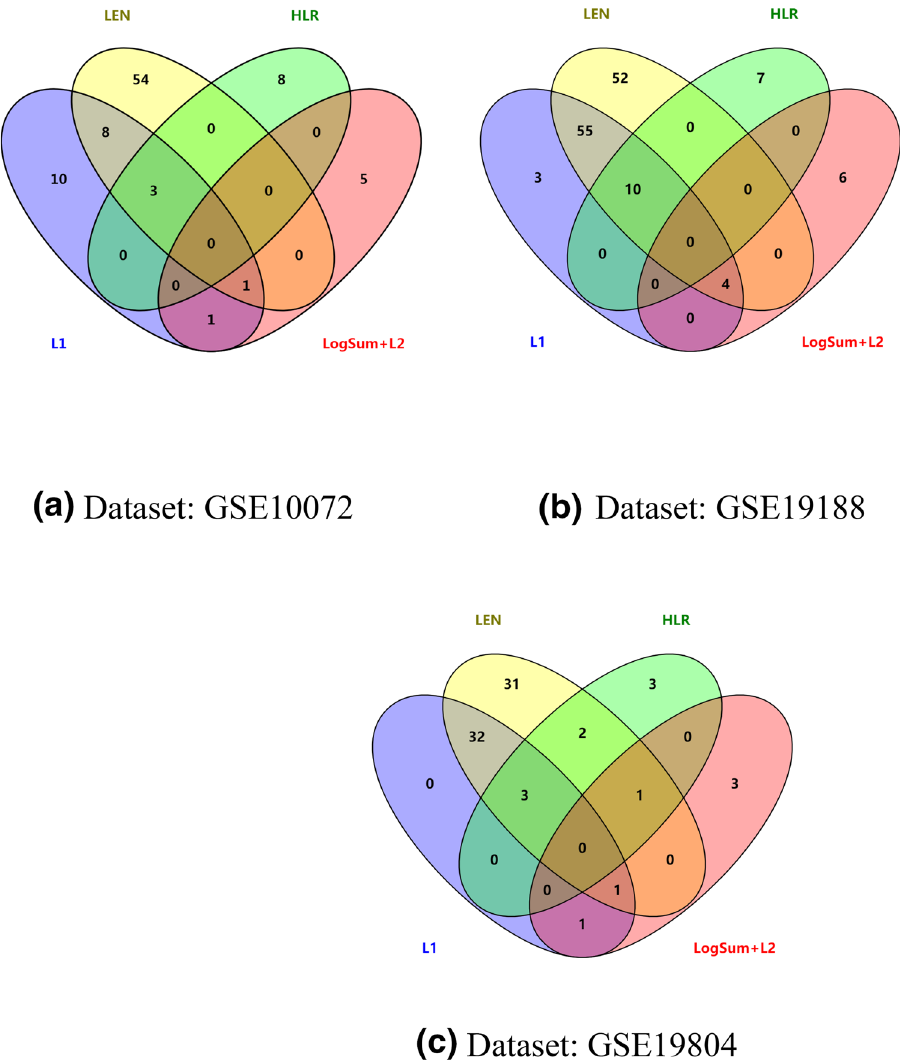
Figure 4. Venn diagram analysis of the results of L 1 , L EN , HLR and LogSum + L 2 regularization